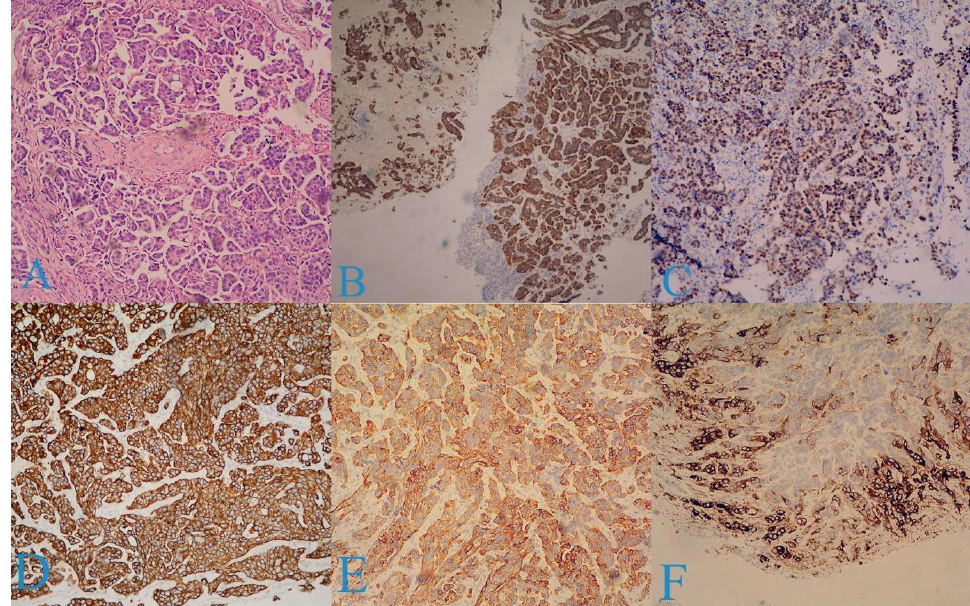
Figure 2. Histologic findings: ( A ) tumor consisting of micropapillae, nests, and strands (×25 H&E); ( B ) p16 (+) in over 90% of the tumor cells; ( C ) p63 (+) in over 80% of the cells; ( D ) CK7 (+) in over 90% of the cells; ( E ) CK20 (+) in over 50% of the cells; ( F ) CEA (+) in the peripheral layers of tumor nests. The tumor was diagnosed as PSCC.